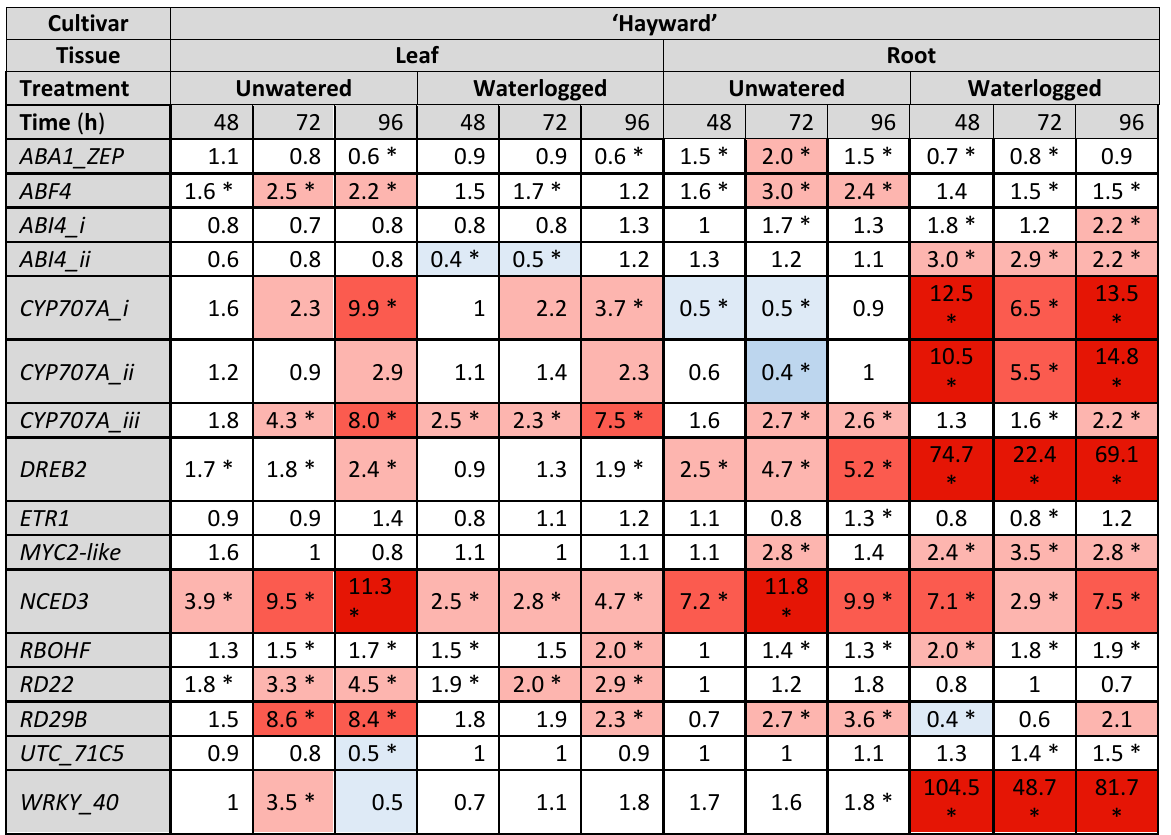
Figure 6. Fold-change in gene expression induced by water stress conditions in leaf and root tissue of Actinidia chinensis var. deliciosa ‘Hayward’ kiwifruit plants after 24 h, 48 h, 72 h and 96 h of water stress treatments in 2021. Plants in the no water treatment did not receive any watering from time 0 h, while waterlogged plants were subjected to constant water at quarter pot height. Plants in the control treatment received the standard watering regime of 12 minutes, twice daily. There were five replicate plants/time/treatment. Gene expression was quantified by PlexSet NanoString using Actin2 , Glyceraldehyde 3-phosphate dehydrogenase ( GAPDH ), Protein phosphatase 2A ( PP2A ) and ubiquitin-conjugating enzyme ( UBC ) as the reference genes. The genes of interest are shown in the left-most column. Statistical analysis was performed at the log₂ scale, and the heat map shows fold change data between water stressed plants and the control at the same time point. Red shades (as defined in Figure 2) indicate an up-regulation relative to the control, whilst blue represents down-regulation relative to the control. Fold changes of 0.5 – 2 are often considered to be statistically unreliable [25 – 27]. Statistically significant differences from the control at individual time points, as determined by ANOVA at ( p ≤ 0.05 ) are identified with an asterisk.